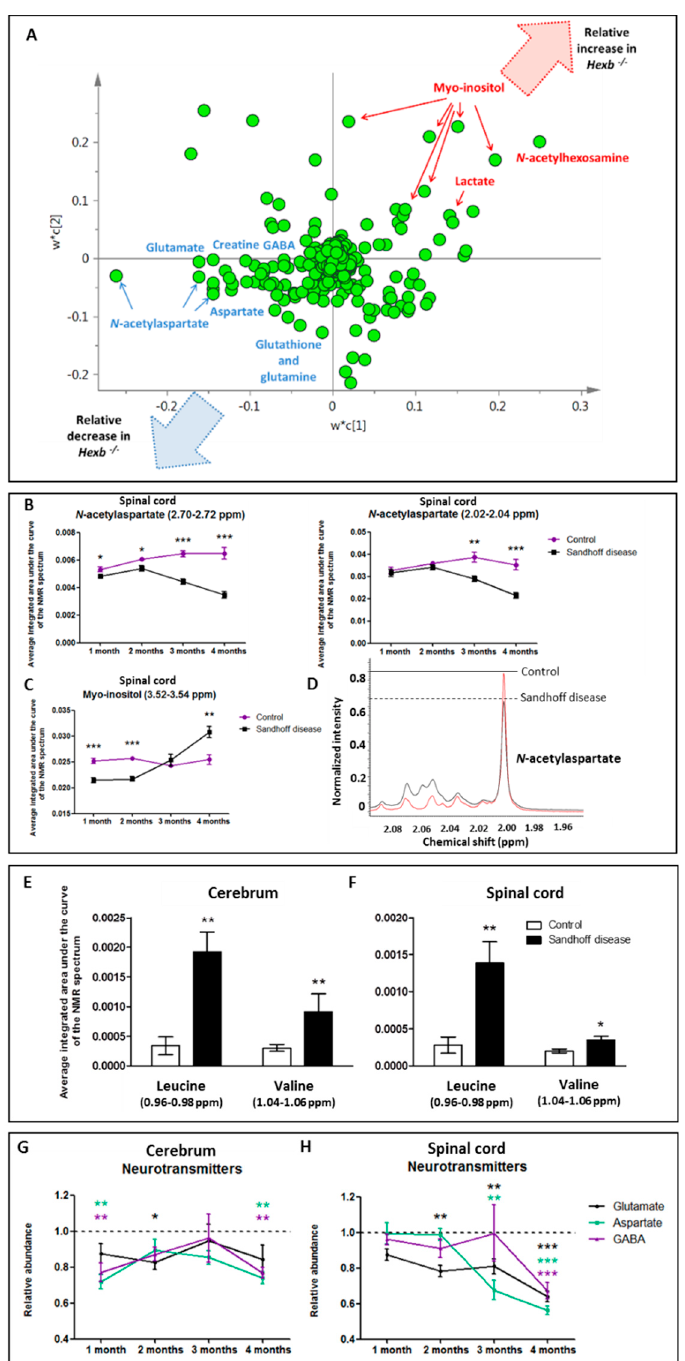
Figure 5. Metabolic variations between Hexb − / − mice and controls from one to four months of age detected using NMR spectroscopy. ( A ) PLS-DA loading scatter plot from the analysis by 1 H-NMR spectroscopy of spinal cord tissue from four- month-old control and Hexb − / − mice. The most discriminatory decreases in Hexb − / − mice are labelled in blue and the most discriminatory increases in Hexb − / − mice are labelled in red. ( B ) concentration of N -acetylaspartate in spinal cord tissue from one to four-month-old control and Hexb − / − mice (two resonances shown). ( C ) concentration of myo-inositol in spinal cord tissue from one to four-month-old control and Hexb − / − mice. ( D ) expanded region (1.96–2.095 ppm) from the 1 H-NMR spectra of cerebrum tissue from four-month-old control Hexb − / − mice. The resonance corresponding to N -acetylaspartate is decreased in the Hexb − / − mouse. ( E ) concentration of leucine and valine in cerebrum tissue from one-month-old control and Hexb − / − mice. ( F ) concentration of leucine and valine in spinal cord tissue from one-month-old control and Hexb − / − mice. ( G ) concentration of three neurotransmitters, aspartate, glutamate and GABA, in cerebrum tissue from Hexb − / − mice. Control concentration is set to 1. ( H ) concentration of aspartate, glutamate and GABA, in spinal cord tissue from control